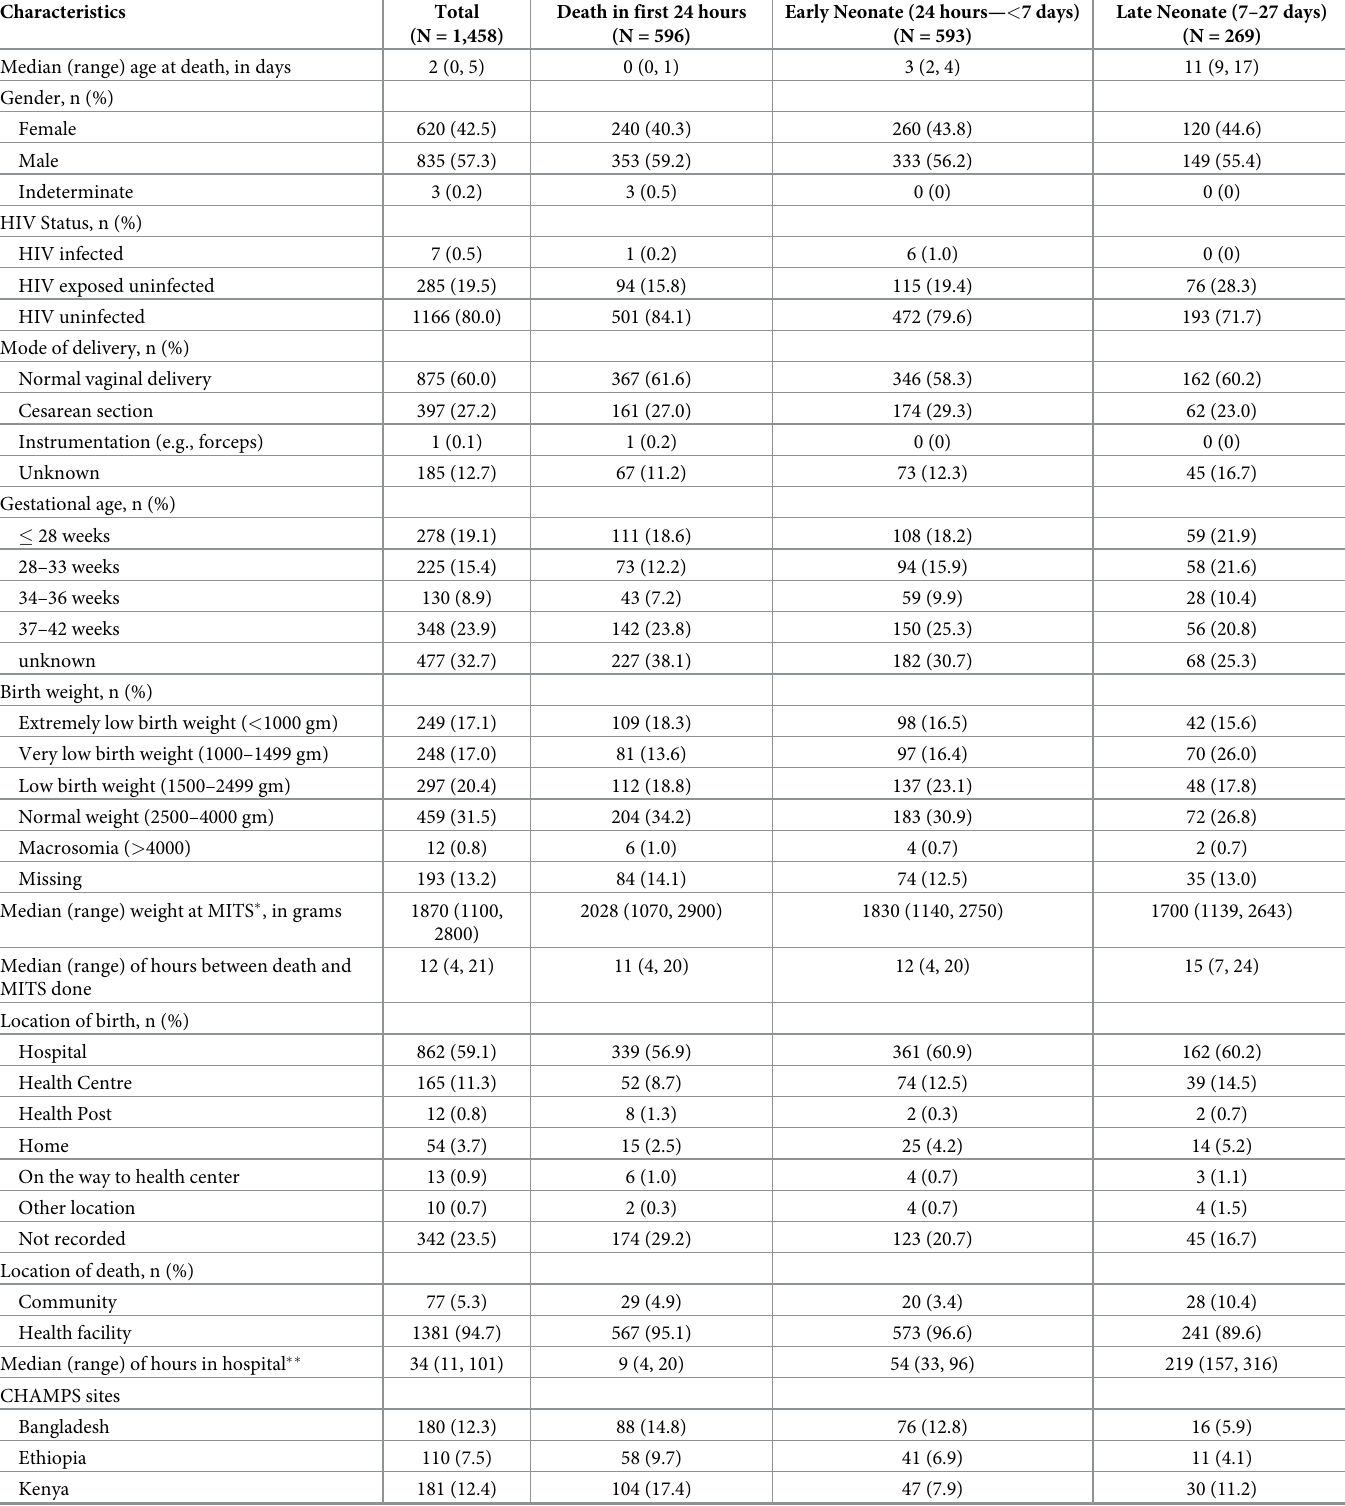
Table 1. Characteristics of deaths enrolled in CHAMPS that occurred during the neonatal period, by age at death (2016–2021).